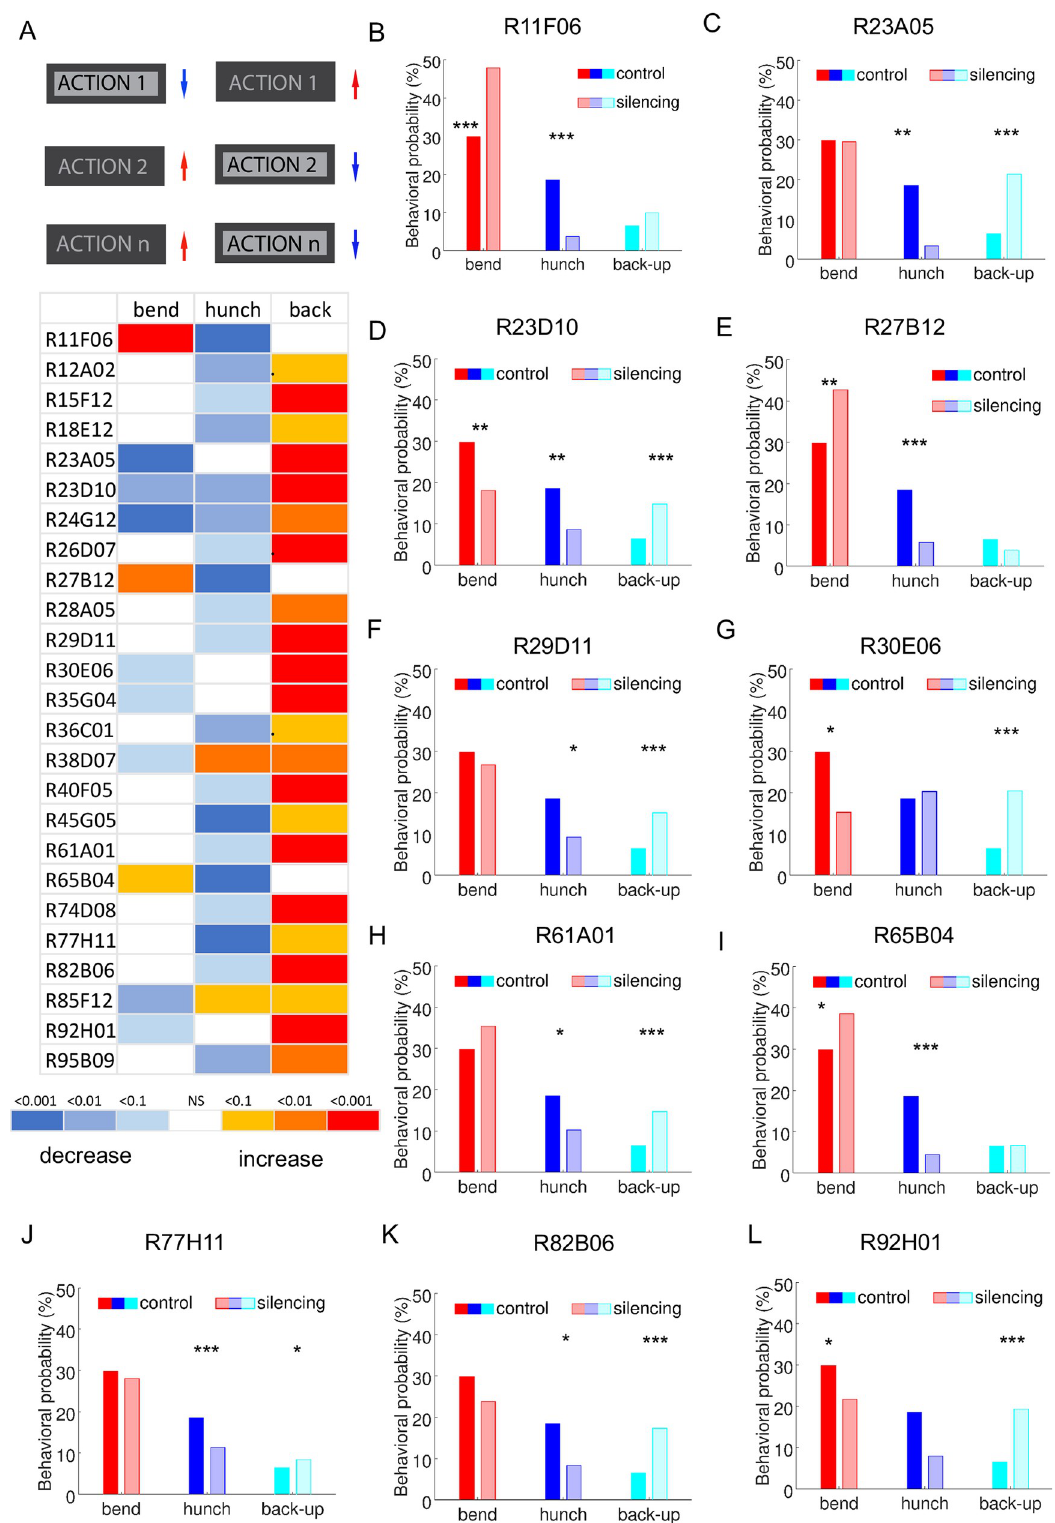
Fig 5. Competitive interaction hit lines. A . Top panel : schematic of the competitive interaction phenotype. Bottom panel : Heatmap. Phenotypic summaries using selected behaviors (Hunch, Bend and Back-up) for the “competitive interaction” hits